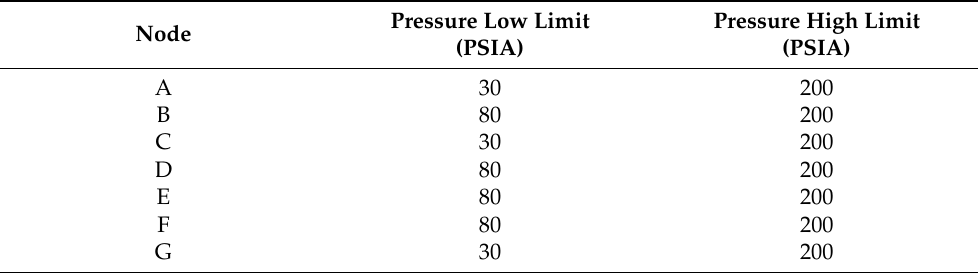
Power Systems: 2009.